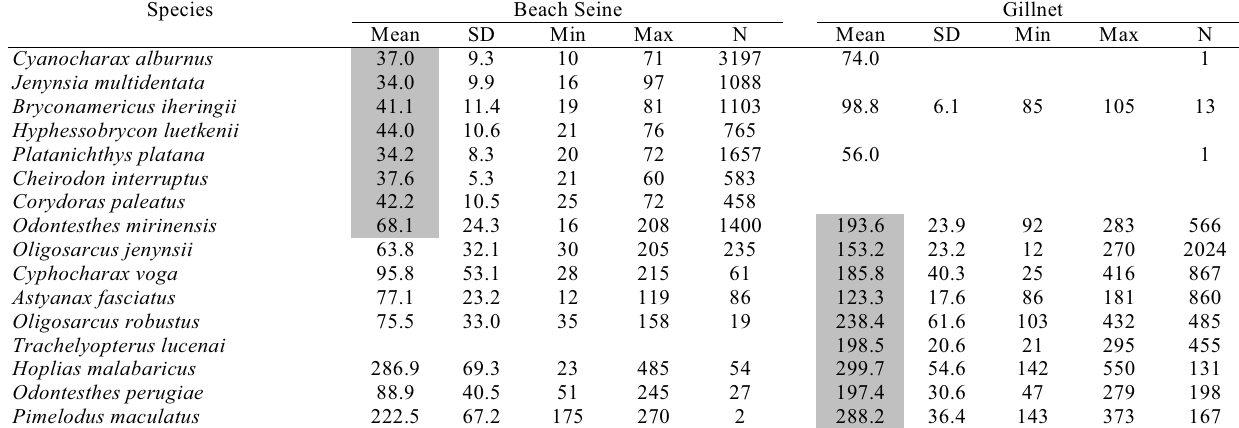
Table 3. Mean, standard deviation (SD), minimum (Min), maximum (Max) and number of cases (N) of total lenght (TL, mm) of the dominant fishes captured by beach seine (shallow margins) and gillnet (pelagic waters) sampling in Taim’s lakes (Flores, Nicola, Jacaré and Mangueira Norte). Dominant species in each gear (according Table 1) are shown in